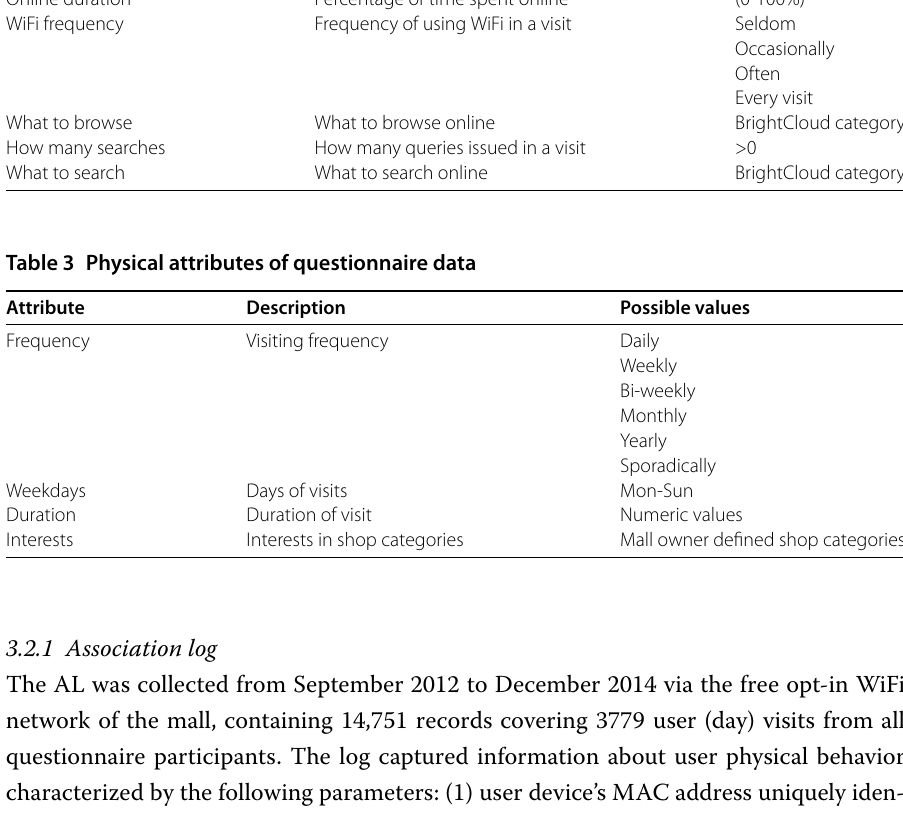
Table 2 Web attributes of questionnaire data Attribute